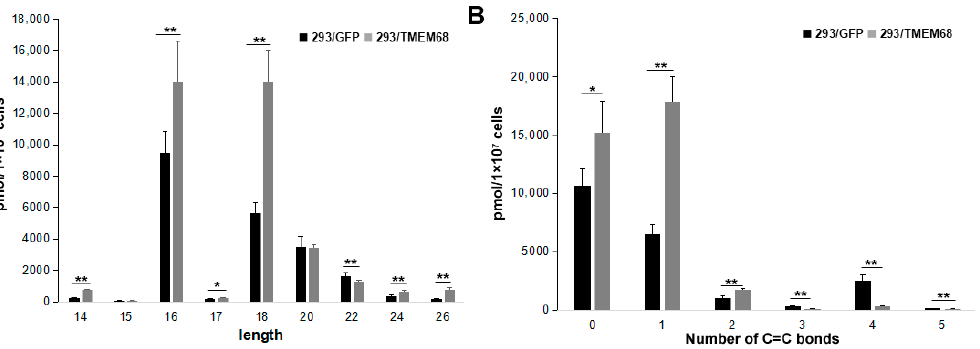
Figure 7. The levels of FFA with different length ( A ) and number of C=C bonds ( B ). Data were presented as means ± SD. Asterisk indicated p values: * p < 0.05, ** p < 0.01, n = 6.